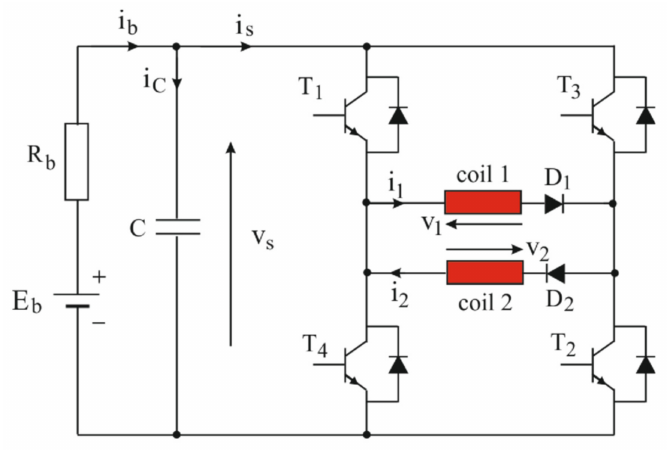
Figure 4. Scheme of the power inverter that supplies the motor coils.